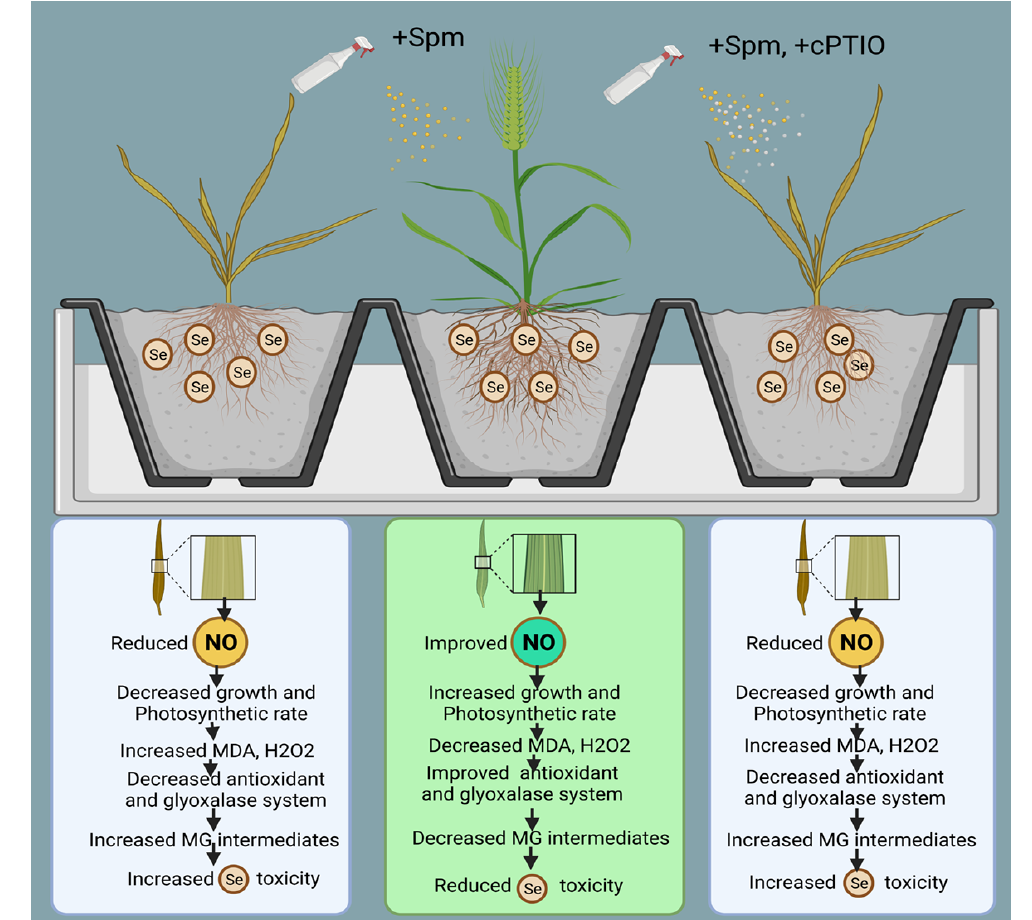
Figure 10. Model showing Spm-induced NO regulation in Se-stressed wheat plant.